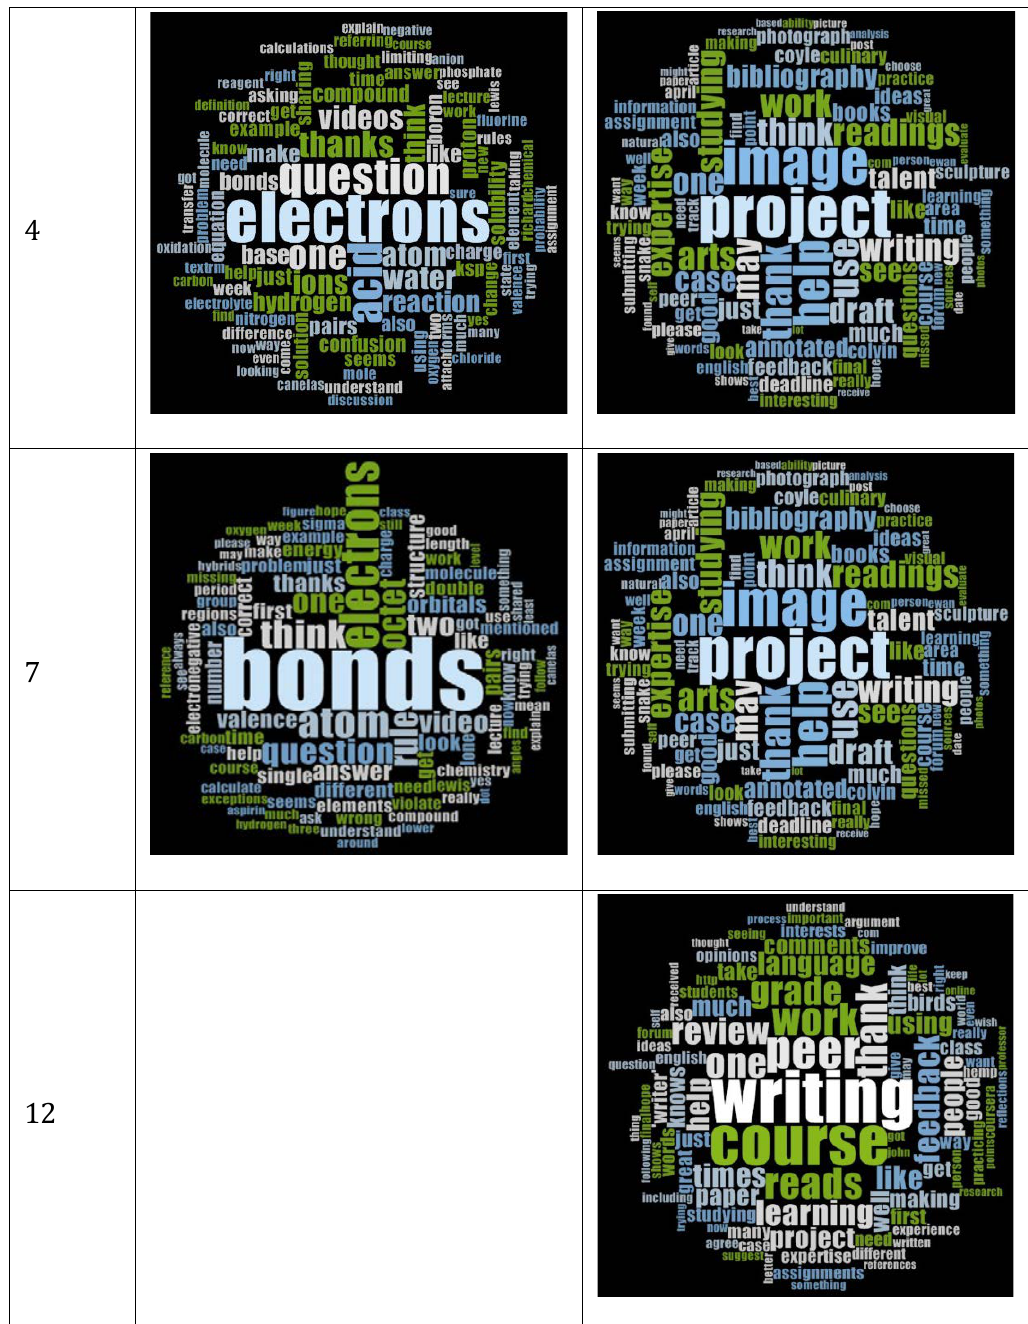
Figure 1. Word frequency in discussion forums by